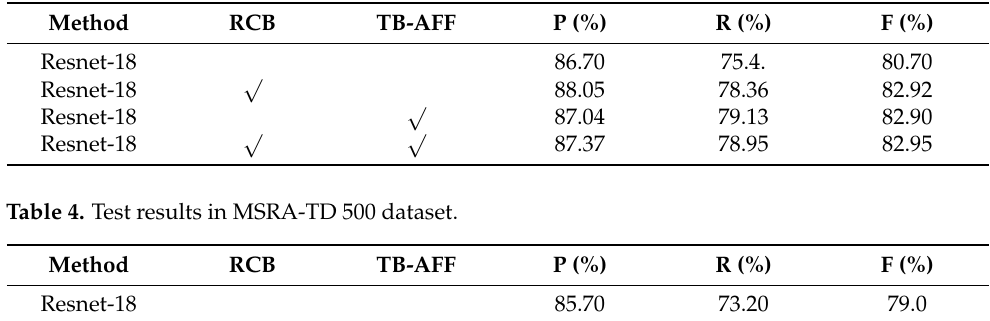
Table 3. Test results in Total-Text dataset.